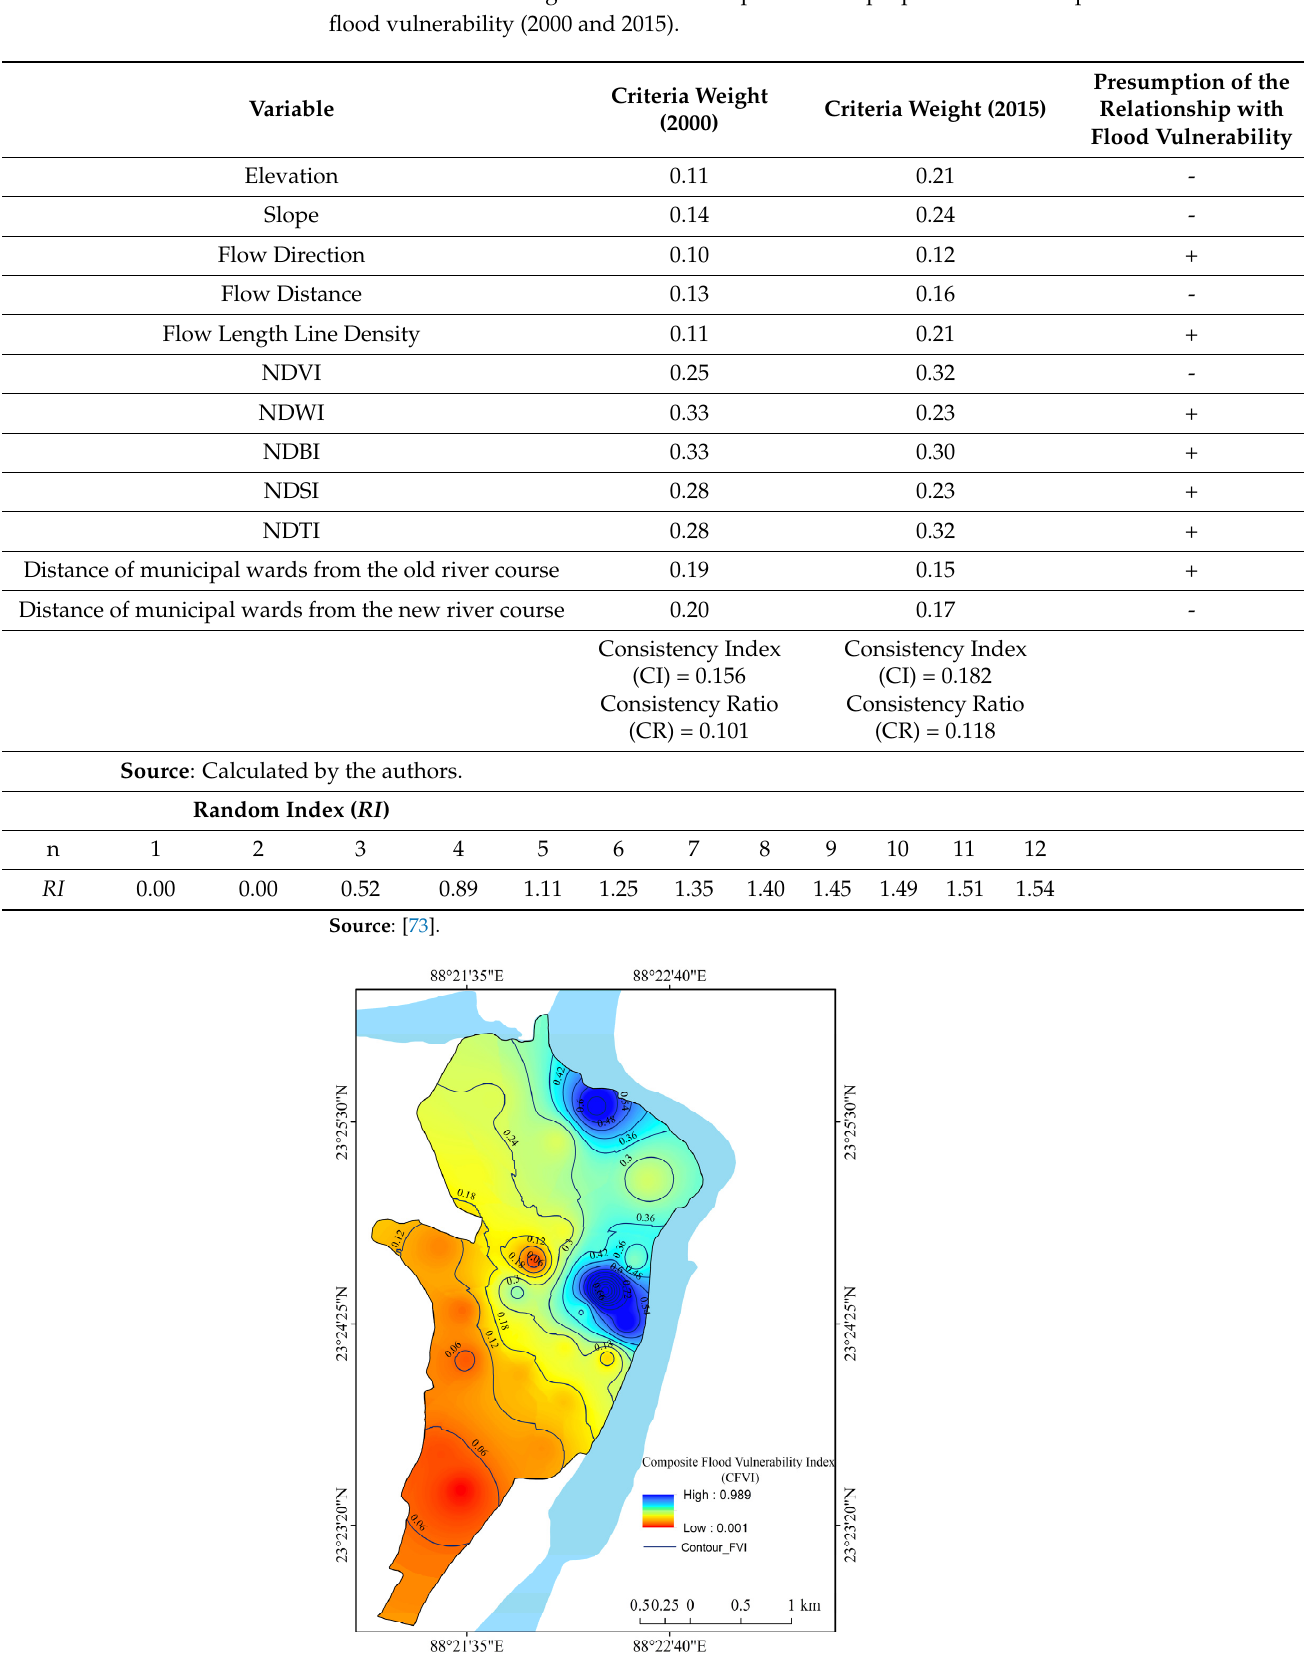
Figure 46. Isoline of CFVI (2000).